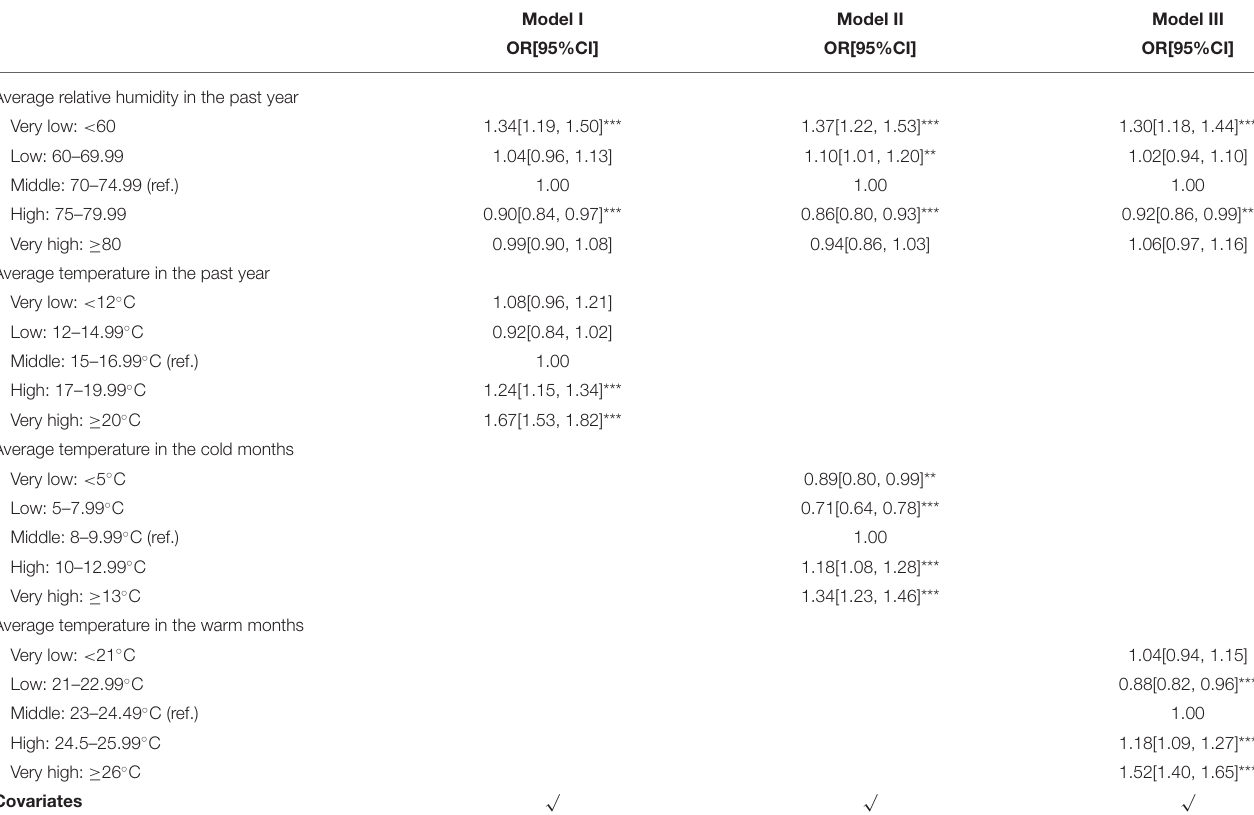
TABLE 4 | Effects of Categorical air relative humidity and temperature on Cataracts: Odds Ratios (OR) from hierarchical GEE models.